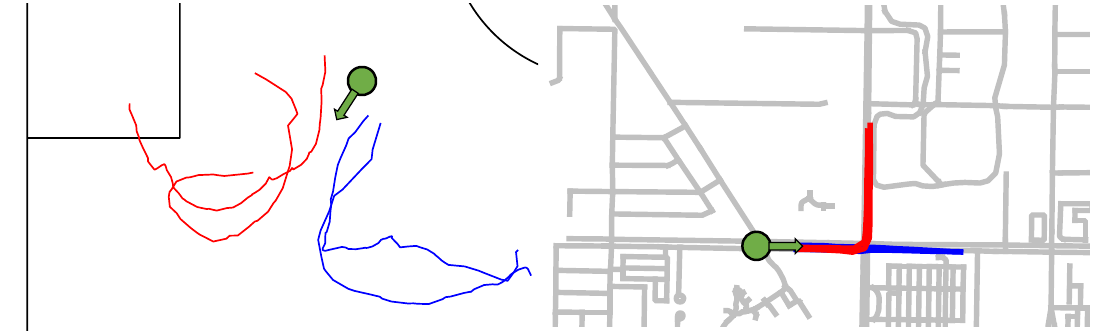
Figure 14. Movement patterns can be used to predict future object movements. In both cases ( left : football, right : traffic) two patterns (red and blue) describe the possible future trajectories of the green object (player/car).